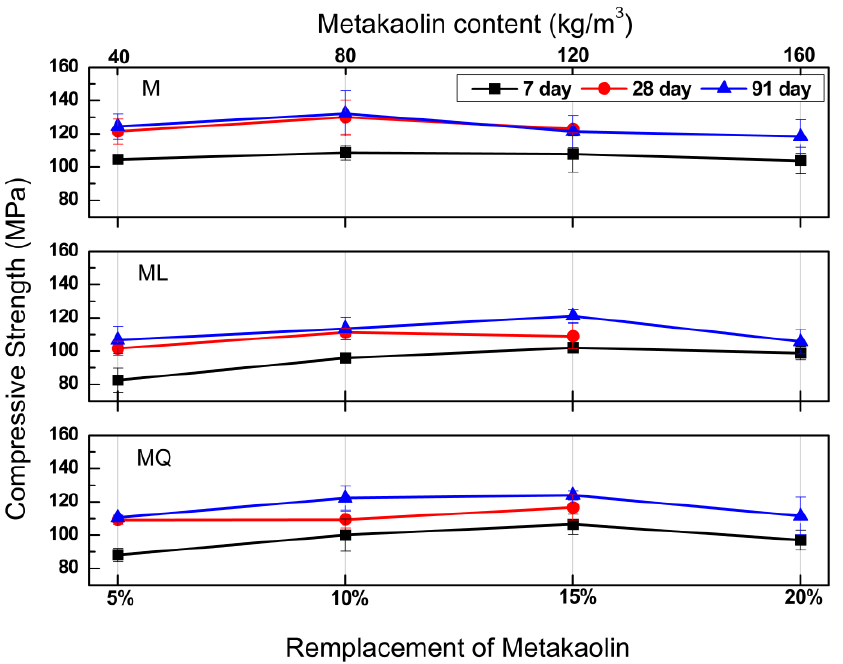
Figure 2. Compressive strength results at the ages of 7, 28 and 91 days for concretes with metakaolin (MK) and limestone (L) or quartz (Q) powders.